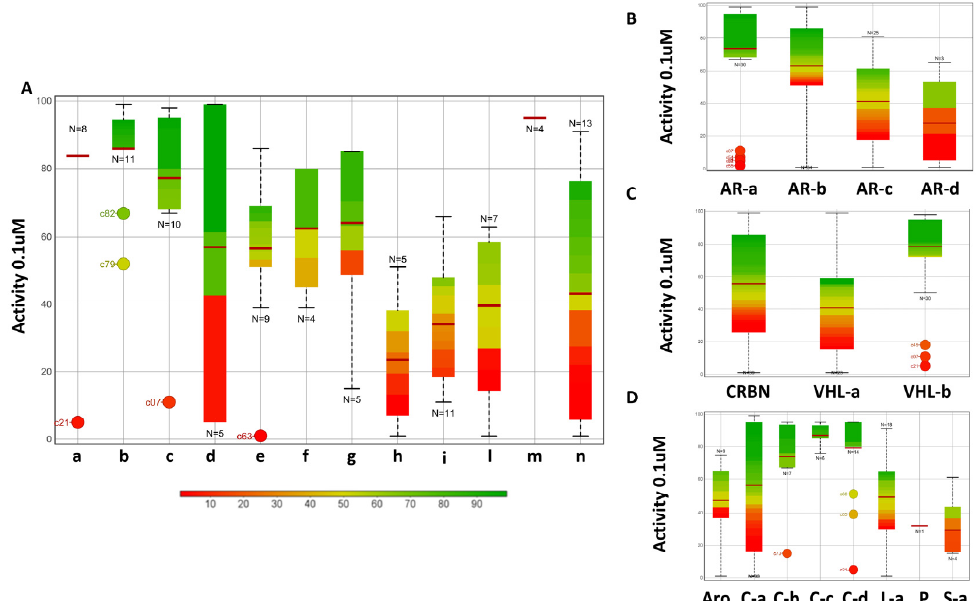
Figure 2. Boxplots reporting the activity distribution per cluster identified through the Bemis–Murcko Molecular Cluster analysis of different building blocks. On the x-axis, the cluster name is reported, and on the y-axis, the activity assessed at 0.1 uM is shown. Boxplots are colored according to the activity of degraders included within the cluster. Moreover, the number of compounds present within the cluster is reported as well, and the average activity value is represented with a red line. ( A ) Entire PROTAC structure. ( B ) Warhead. ( C ) E3 ligand. ( D ) Linker.